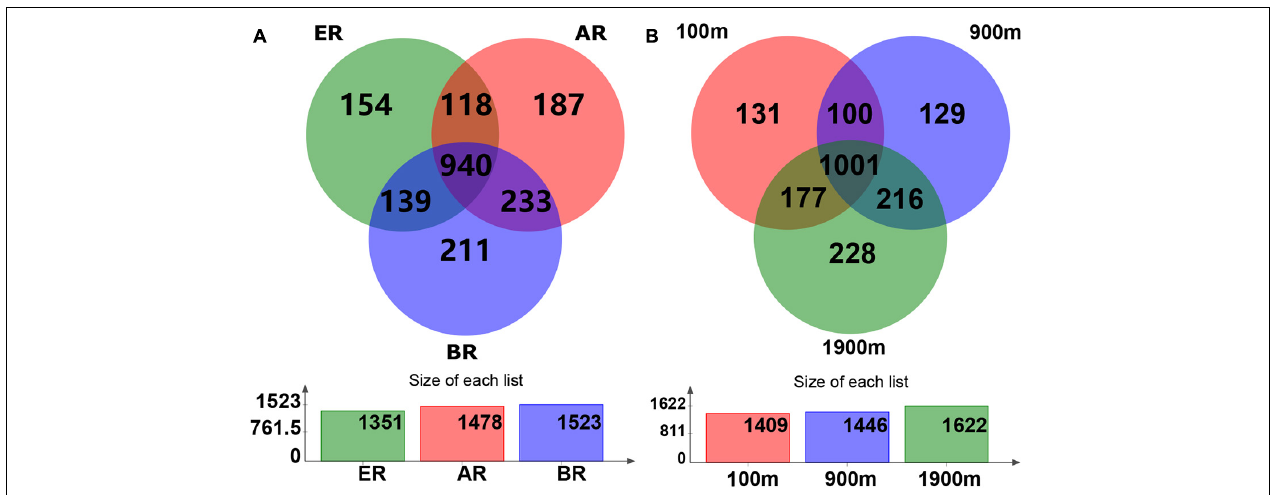
FIGURE 1 | Operational taxonomic unit (OTU) Venn diagram of fungal communities in different routes and at different distances. AR, route (A) ; BR, route (B) ; ER, route